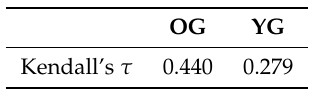
Table 3. Kendall’s τ across